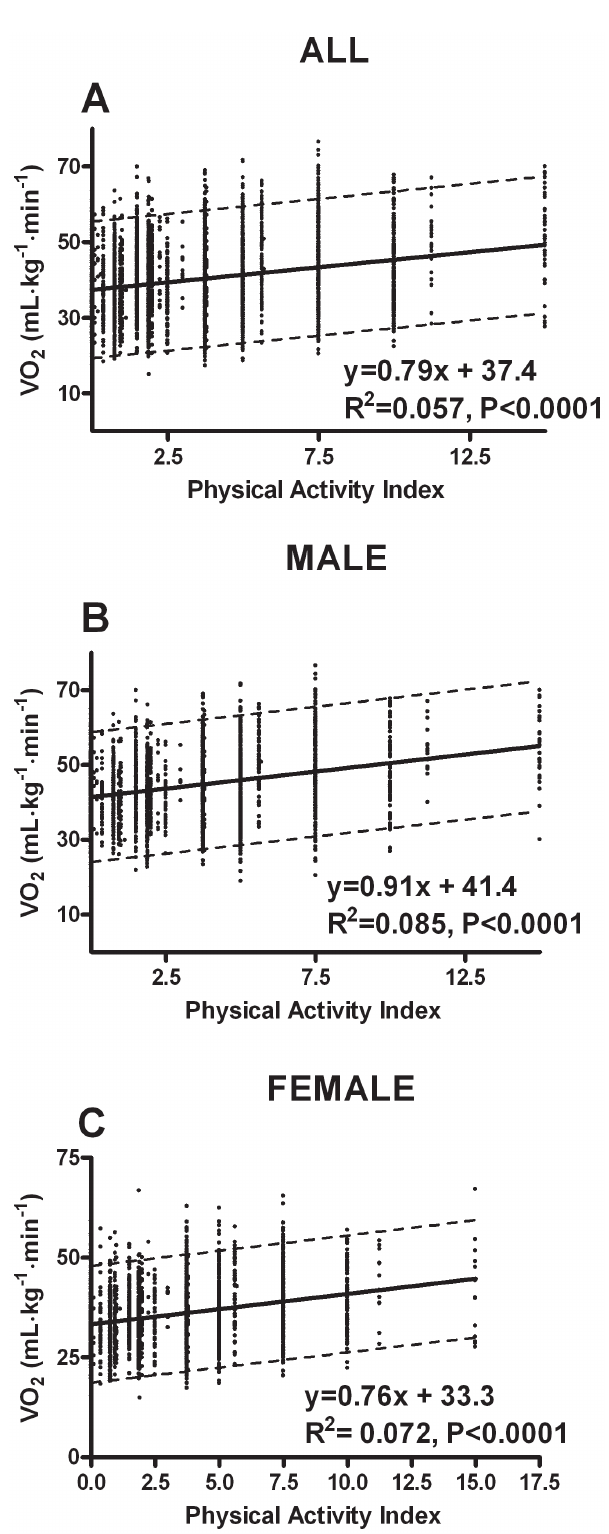
Figure 3. Correlations between physical activity index score and oxygen uptake (VO 2 ).